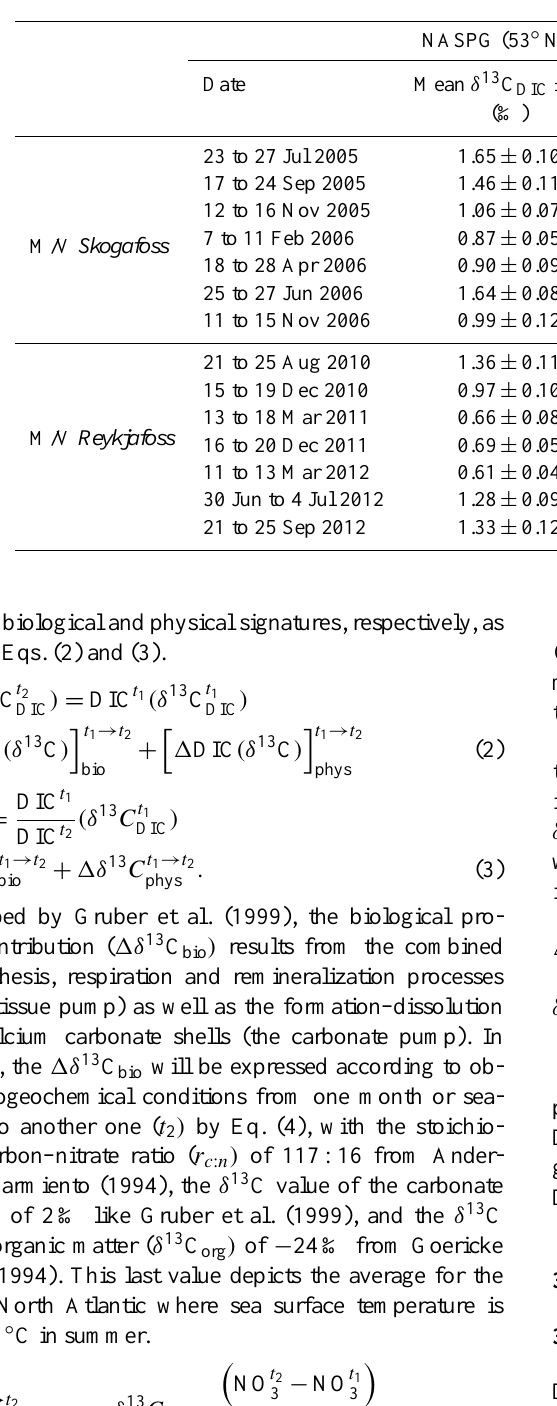
Table 1. Summary of sampling periods conducted on board the merchant vessels Skogafoss and Reykjafoss between Reykjavik (64 ◦ N, Iceland) and Newfoundland (47 ◦ N, Canada) over the 2005–2006 and 2010–2012 periods, respectively. The average values of δ 13 C DIC , DIC and salinity normalized DIC (nDIC) as well as their standard deviation (SD) were estimated for the interior of the North Atlantic subpolar gyre (NASPG 53 ◦ N–62 ◦ N). The number of data ( n ) used to calculate these mean values are indicated in the last